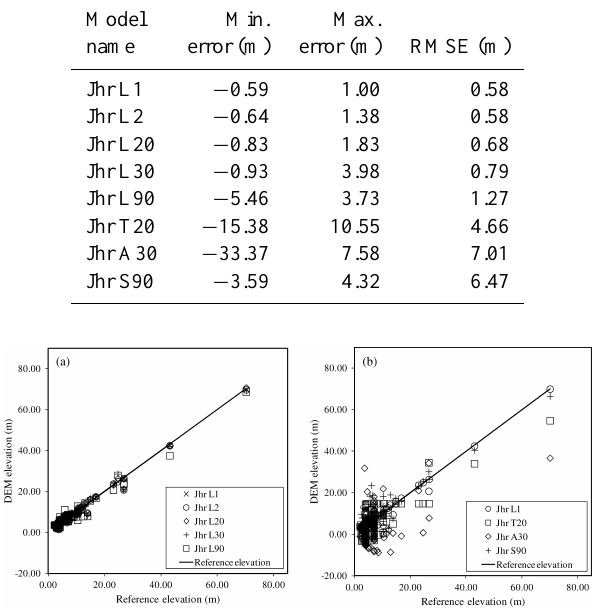
Table 3. Statistics of errors (m) of each DEMs with respect to the GPS control points. Model Min. Max.